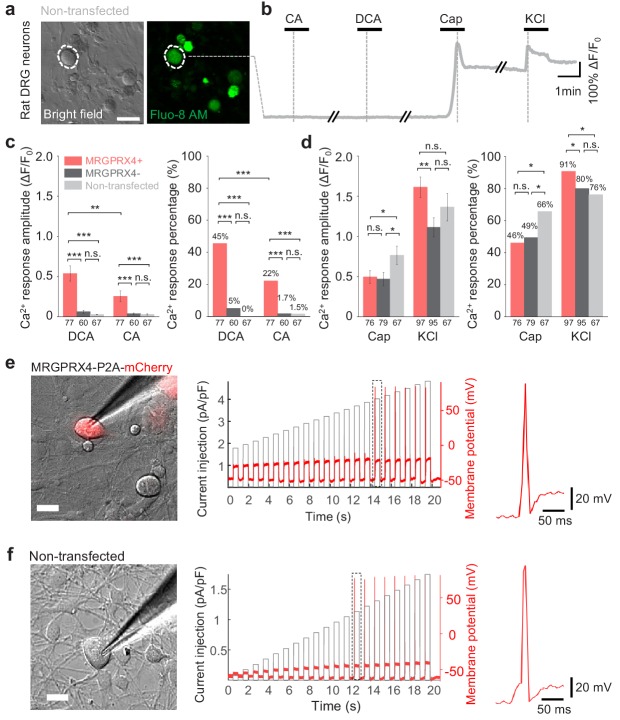
Expressing MRGPRX4 in cultured rat DRG neurons renders the cells responsive to bile acids.(a) Non-transfected cultured rat DRG neurons. A representative neuron is circled by the dash line. Scale bar, 50 μm. (b) Representative traces from the cells indicated in (a). DCA and CA: 10 μM; capsaicin (Cap): 1 μM; KCl: 75 mM. (c, d) Summary and comparison of the amplitude and percentage of Ca2+ signals in response to DCA, CA, capsaicin and KCl in (a, b) and (Figure 5a, b). Responsive neurons were defined as exceeding a threshold of 20% ΔF/F0. n = 60–95 neurons per group. (The n numbers are labeled under each column). All error bars represent the s.e.m.. Student’s t-test and two-proportion z-test (Fisher’s exact test for the 0% percentage), *p<0.05, **p<0.01, ***p<0.001, and n.s. not significant (p>0.05). (e, f) Representative images and recording of electrical stimulation-induced action potentials in cultured DRG neurons from (Figure 5e, f) before DCA treatment. The representative single action potentials in the dotted box are shown in the right. Scale bar, 20 μm.